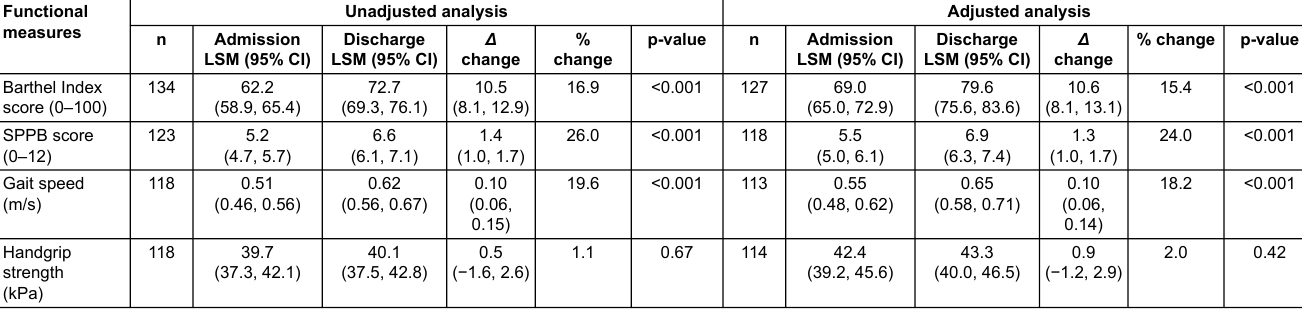
Table 2: Change in functional measures between admission to and discharge from post-acute